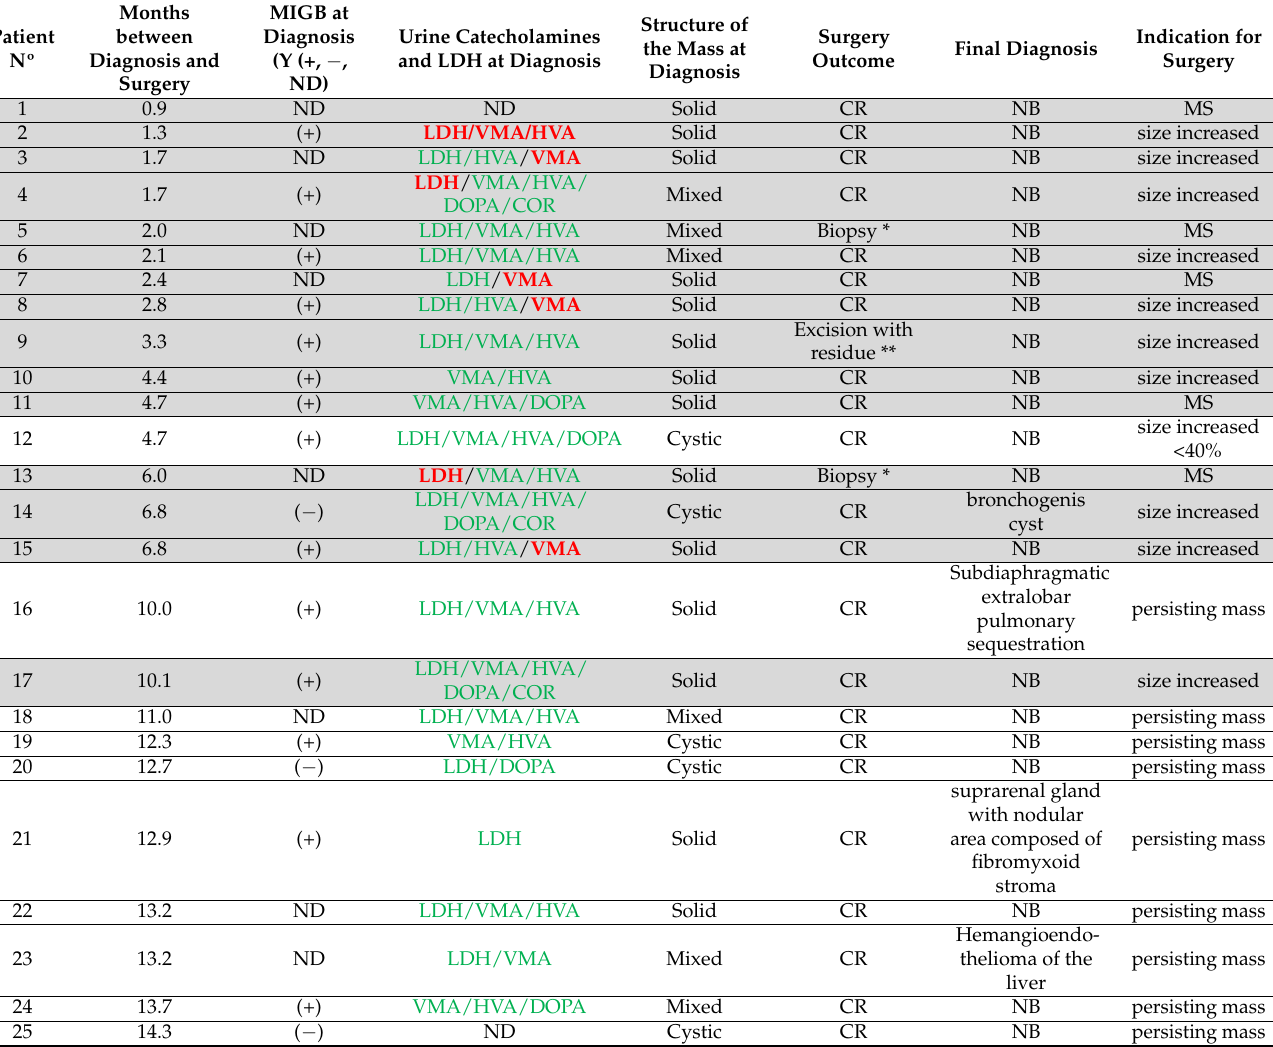
Table 4. Summary of patients who underwent resection. In grey, cases who had an event (MS or increased ≥ 40% in tumor volume). In white, cases who had a persisting mass at the end of the 48 weeks observation period and were referred to surgery. Urine catecholamines (VMA/HVA/DOPA) and LDH are shown in red in values above the 2 × the upper normal value (>2 u.n.v.) and in green if normal ( ≤ 2 u.n.v). CR; complete resection; ND: not done; GNB; ganglioneuroblastoma; GN: ganglioneuroma: NB; neuroblastoma.